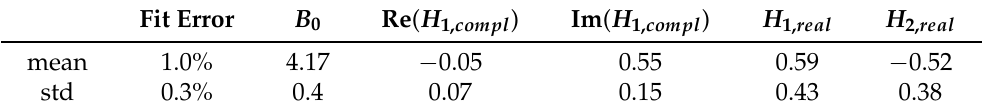
Table 3. Second hypothesis